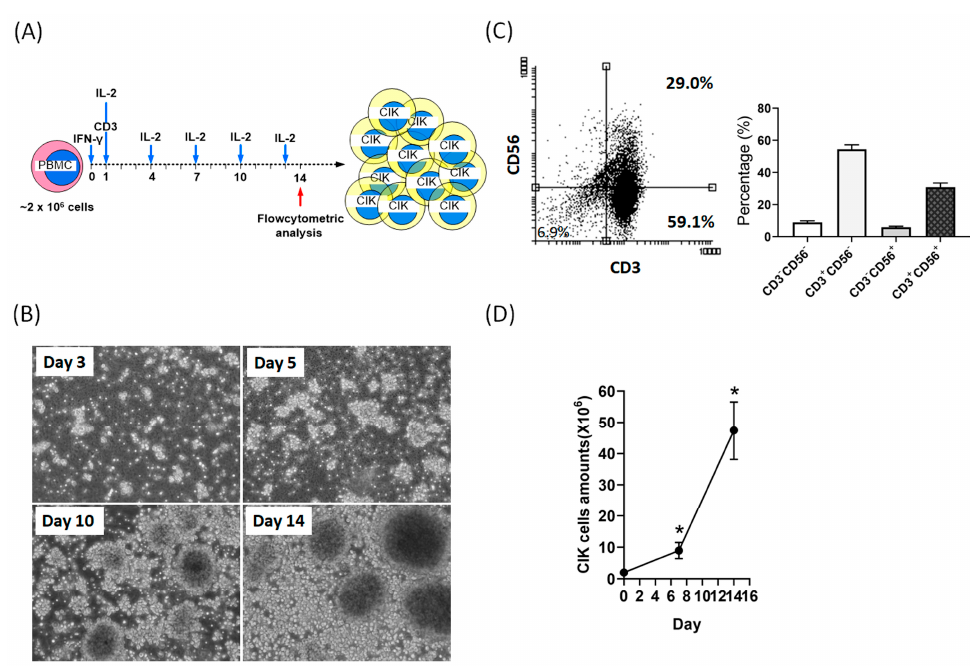
Figure 1. Cell preparation, morphology, expression of specific CD markers, and total amounts of cytokine-induced killer (CIK) cells. ( A ) Overview of the CIK cell preparation schedule. ( B ) CIK cells were observed under a microscope on day 3, 5, 10 and 14 after induction of peripheral blood mononuclear cells (PBMCs) (magnification, × 250). ( C ) At day 14 after induction, the cell phenotype (CD3+CD56+) was identified by flow cytometry. The mean percentage of CD3+CD56+ cells from the six donors was about 32% ± 5%. ( D ) CIK cell numbers were measured using a cell counter (LUNA automated cell counter) at the indicated time points. After 14 days of cell culture, the total number of CIK cells expanded by more than 24-fold. Data from three independent experiments were used for statistical analysis and * p < 0.05.